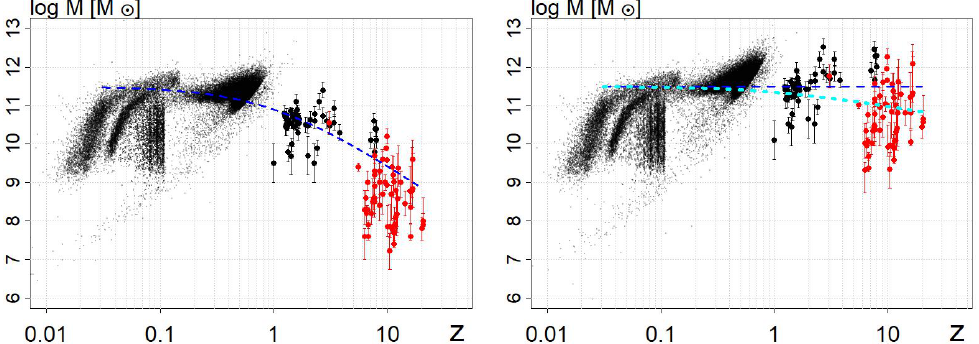
Figure 6. Left : Masses of high-redshift galaxies as determined within the framework of Λ CDM using the recent JWST observations (red points) and some pre-JWST observations (black points); the dashed curve indicates the factor ( 1 + z ) − 2 of the distance-luminosity relationship in the standard cosmology; Right : the same masses corrected for the factor ( 1 + z ) − 2 in order to transform them to the static-Universe